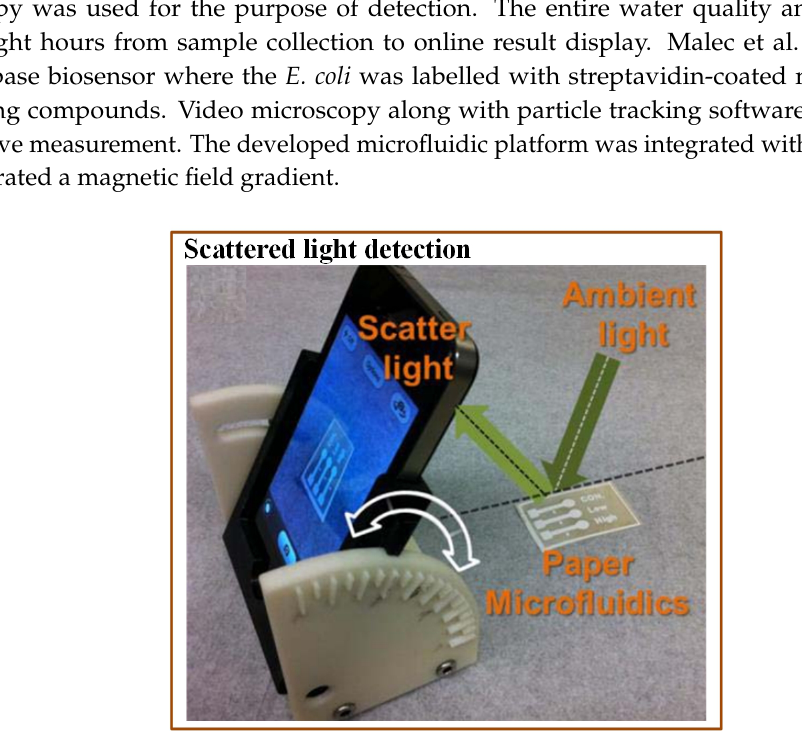
Figure 10. Scheme indicating a mobile-based multichannel paper chip for rapid E. coli detection